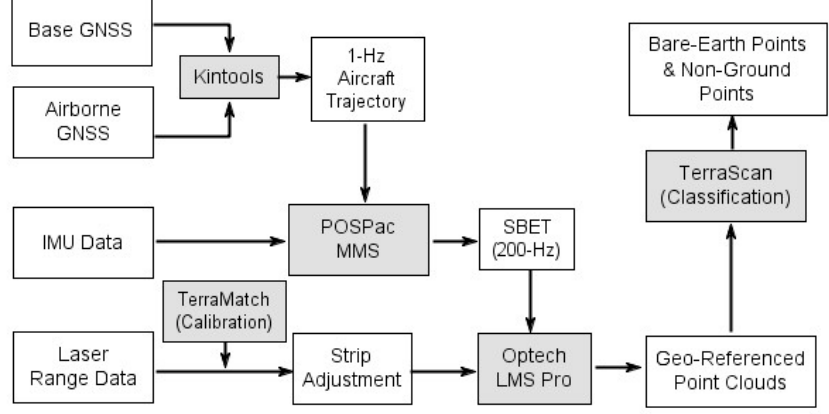
Figure 2. The workflow for airborne laser scanning (ALS) data post-processing.